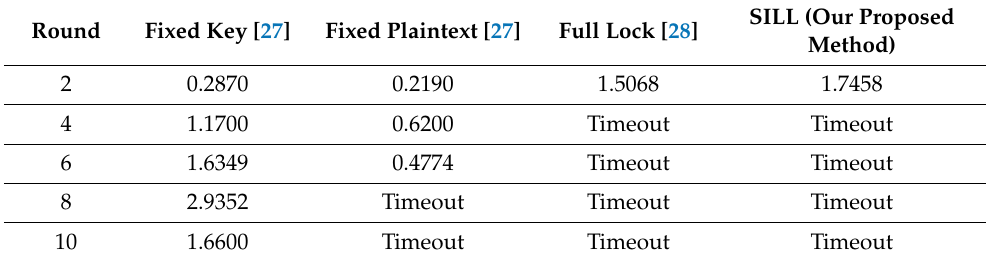
Table 4. Average SAT attack break time (seconds) on ISCAS85 and c432 benchmarks.